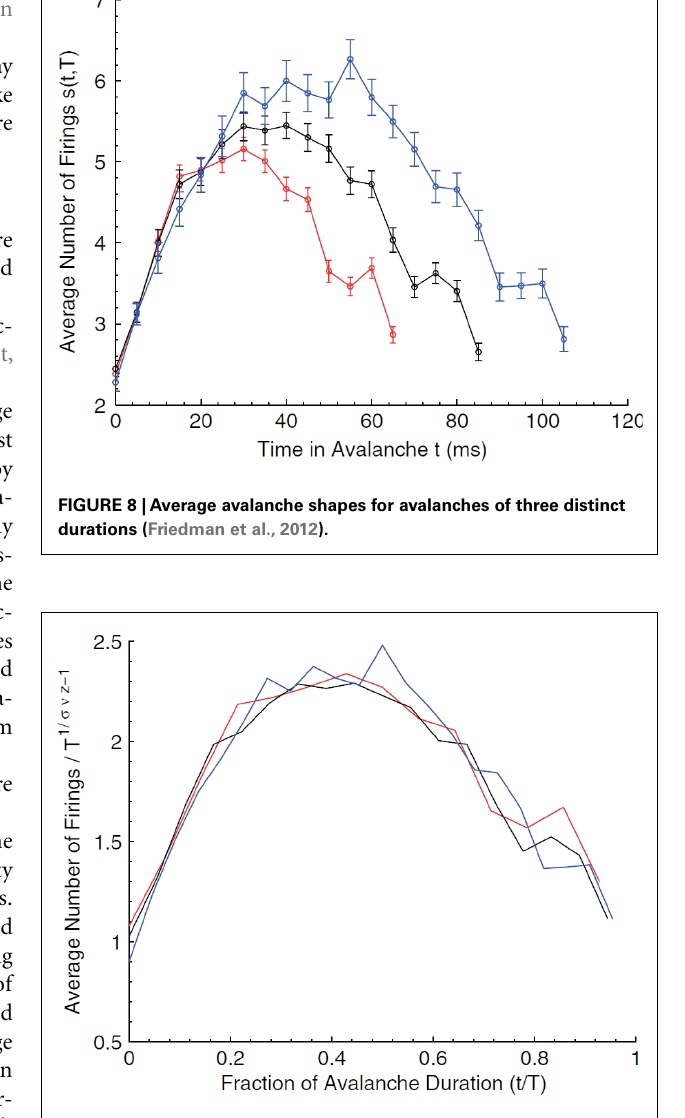
FIGURE 9 | Rescaled avalanche shapes from Figure 8 (Friedman et al.,